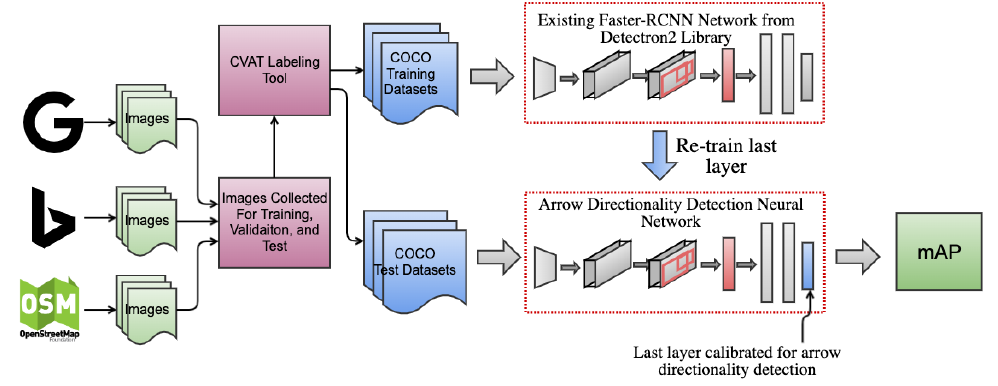
Figure 4. Arrow directionality detection neural network